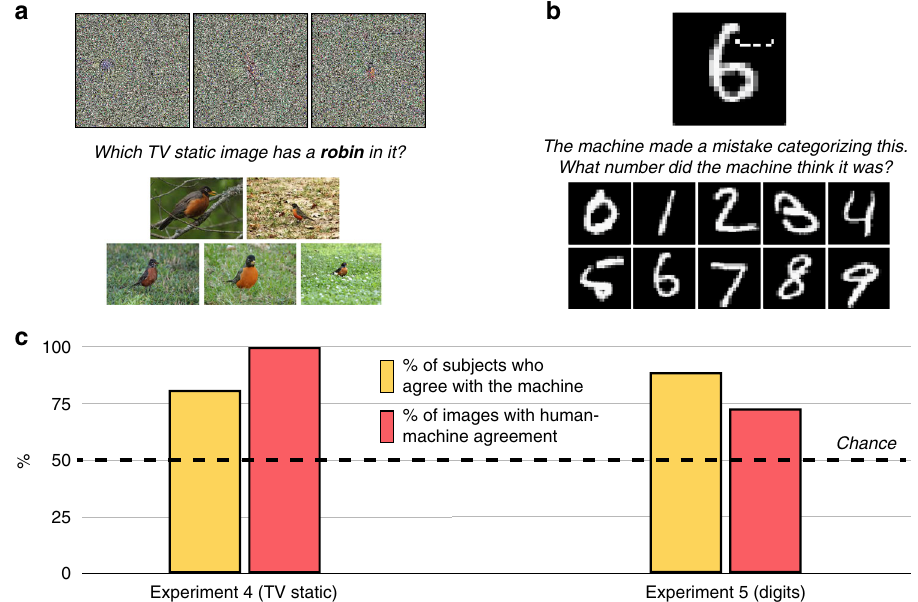
Fig. 3 Classi fi cation with directly encoded fooling images and perturbed MNIST images. a In Experiment 4, 200 subjects saw eight directly encoded “ television static ” images at once (though only three are displayed here); on each trial, a single label appeared, along with fi ve natural photographs of the label randomly drawn from ImageNet (here, a robin [and represented in this fi gure using public-domain images instead of ImageNet images]). The subjects ’ task was to pick whichever fooling image corresponded to the label. b In Experiment 5, 200 subjects saw 10 undistorted handwritten MNIST digits at once; on each trial, a single distorted MNIST digit appeared (100 images total). The subjects ’ task was to pick whichever of the undistorted digits corresponded to the distorted digit (aside from its original identity). c Most subjects agreed with the machine more often than would be predicted by chance responding, and most images showed human-machine agreement more often than would be predicted by chance responding (including every one of the television static images). For Experiment 4, the 95% con fi dence interval for the % of subjects with above-chance classi fi cation was [75.5% 87.3%], and [63.1% 100%] (one-sided 97.5% con fi dence interval) for the % of images with above-chance classi fi cation. For Experiment 5, these intervals were [84.2% 93.8%] and [64.3% 81.7%], respectively. Across both experiments, these outcomes were reliably different from chance at p <0.001 (two-sided binomial probability